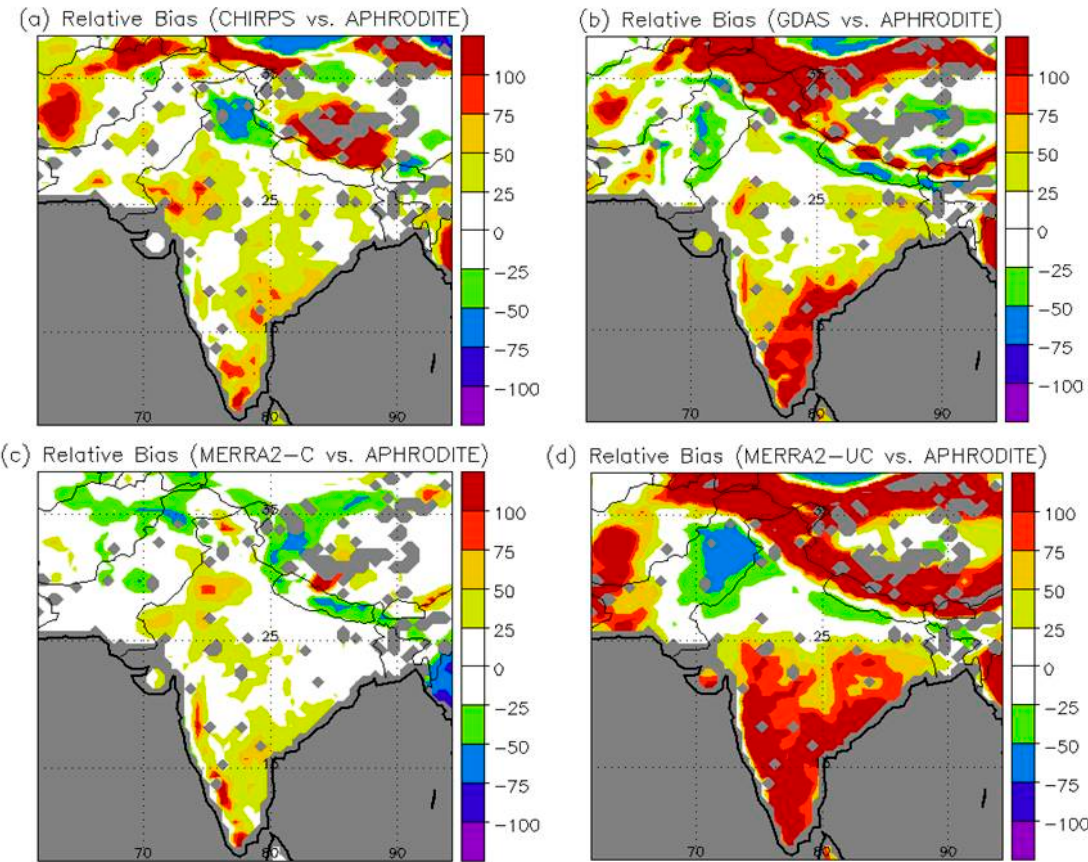
Figure 1. Relative bias (%) of climatology of annual precipitation based on the period from 2001 to 2007 between APHRODITE and ( a ) CHIRPS, ( b ) GDAS, ( c ) MERRA2-C, and ( d ) MERRA2-UC. The grey color indicates a region with no data.